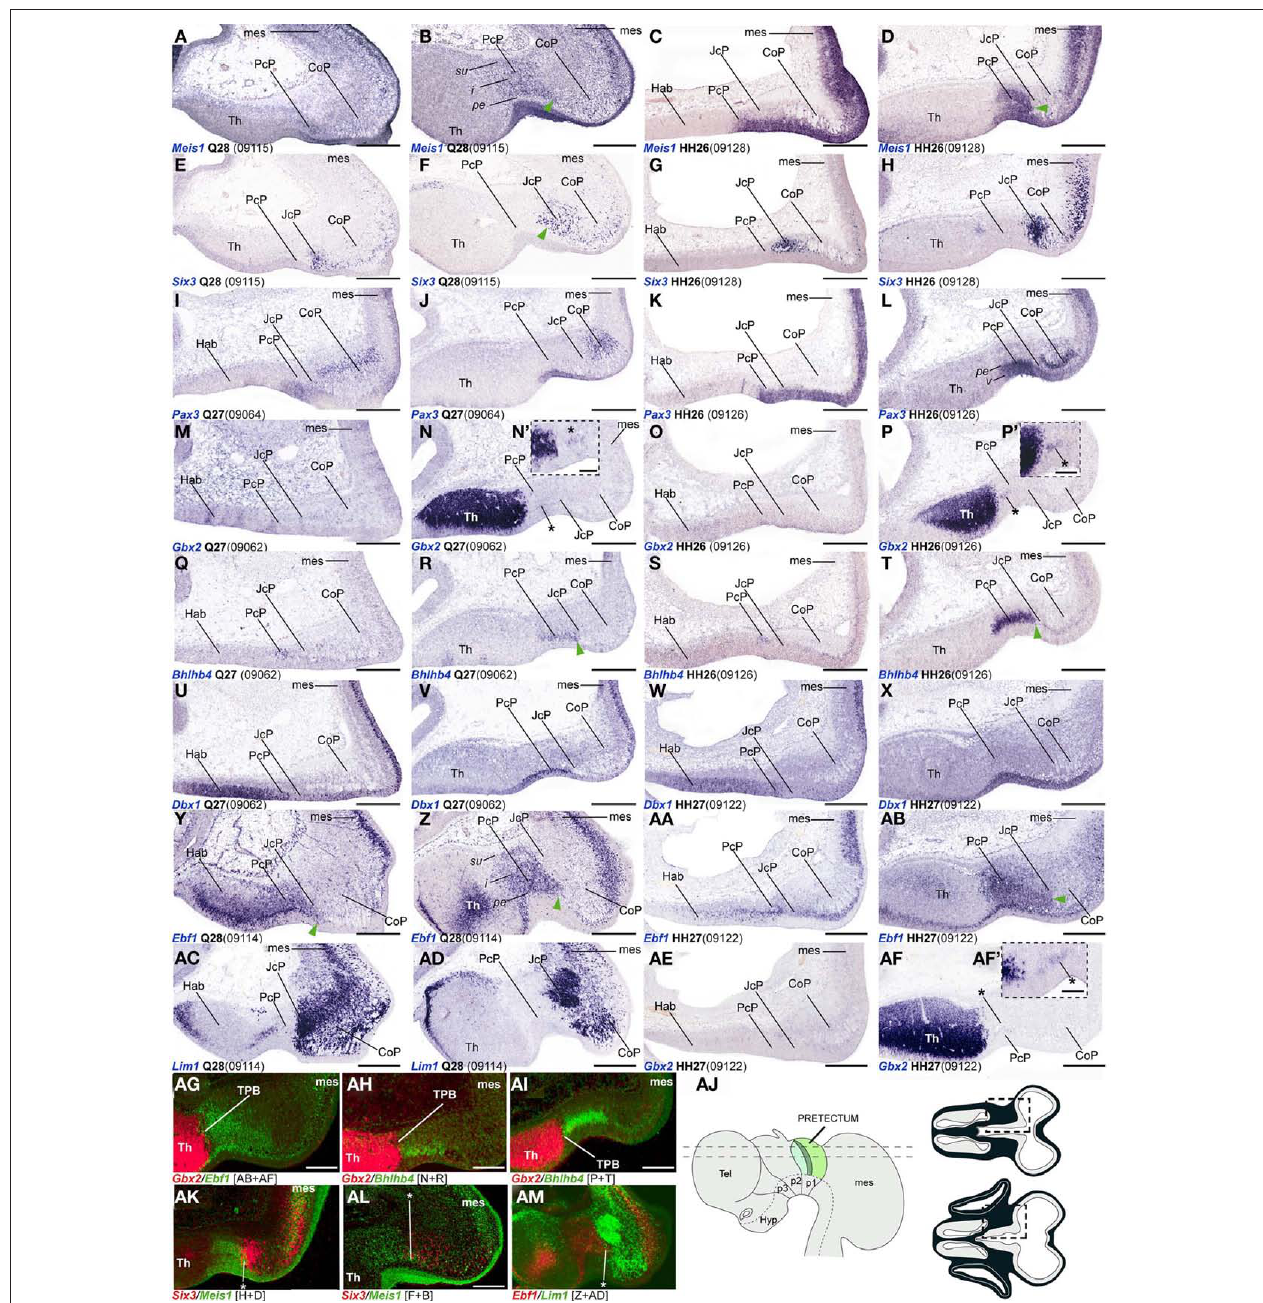
successive rows represent corresponding section levels (though sometimes a different specimen is compared), so that different gene patterns are compared vertically. Green arrowheads in (B,D,F,r,T,Y,Z,AB) and asterisks in (AK–AM) indicate small groups of cells expressing a PcP marker that lie within the molecularly identified JcP domain, suggesting a tangential migratory displacement. Asterisks in (N/N ′ ,P/P ′ ,AF/AF ′ ) : Gbx2 positive cells within the PcP. (AG–AI,AK–AM) Pseudocolored superposition of the indicated pairs of marker domains from adjacent sections, to illustrate boundary relationships between them. (AJ) Schematic view of the brain indicating the two horizontal section planes illustrated in this plate, and the position in such sections of the pretectal region that appears magnified in the panels (dashed boxes). Scale bars = 300 μm for (A–AM) and 100 μm for (N ′ ,P ′ ,AF ′